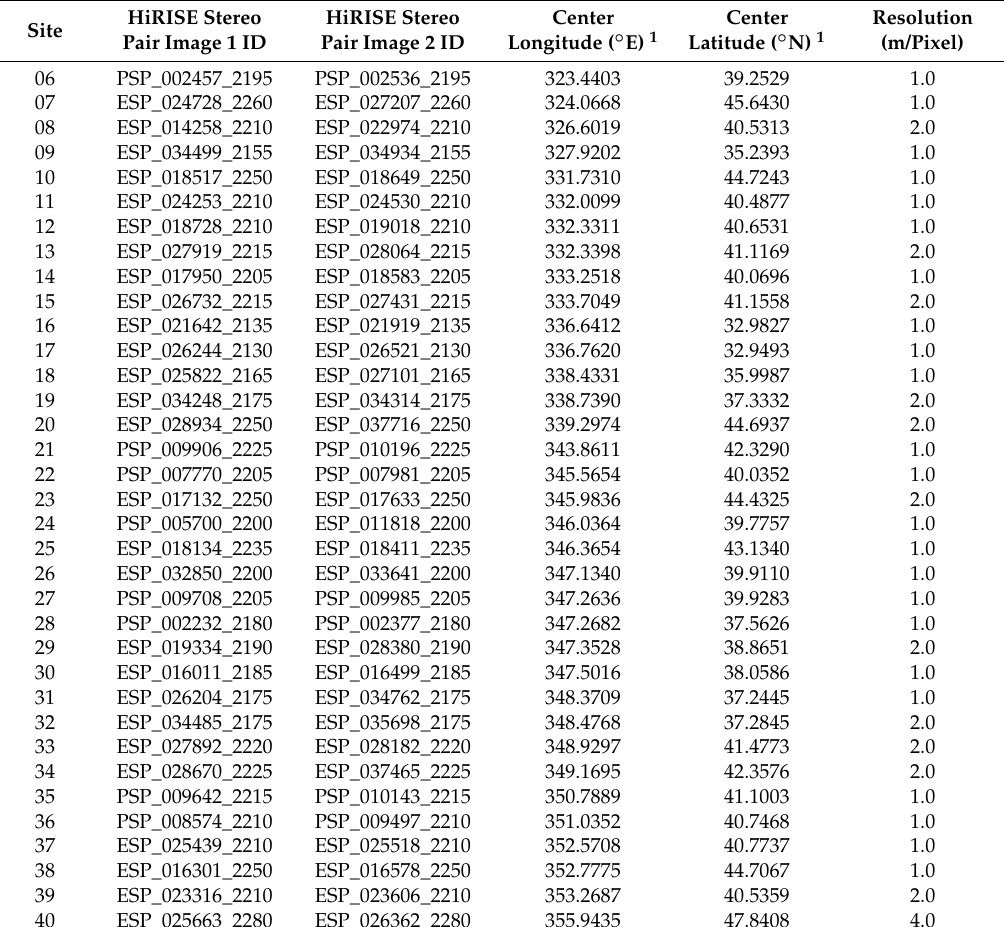
Acidalia region using the ISIS software. All raw and calibrated image data are available in National Aeronautics and Space Administration (NASA) Planetary Data System (PDS). We then used a control network of these points to update camera pointing and spacecraft position information of each HiRISE stereo pair with the ISIS’s module for bundle adjustment, jigsaw